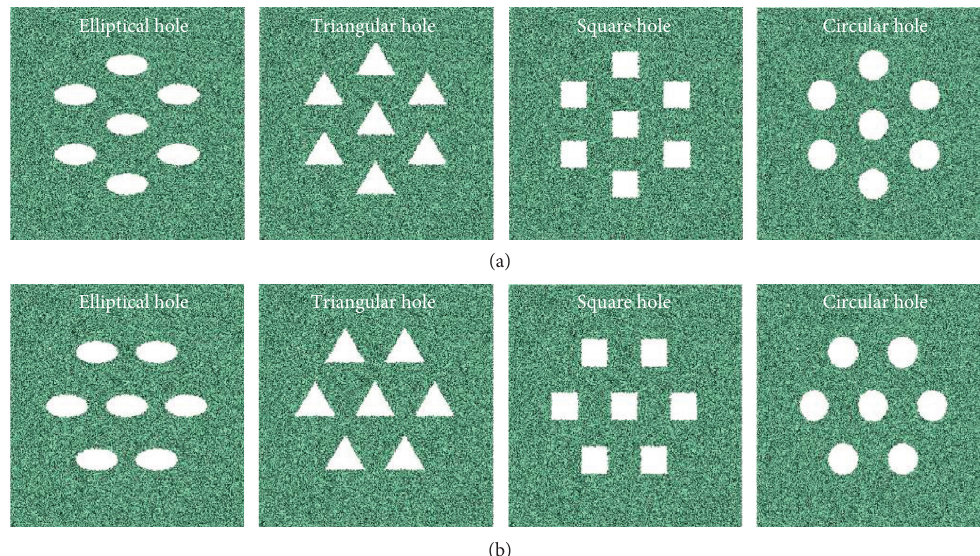
Figure 5: Numerical model. (a) Vertical orientation model. (b) Horizontal orientation model.